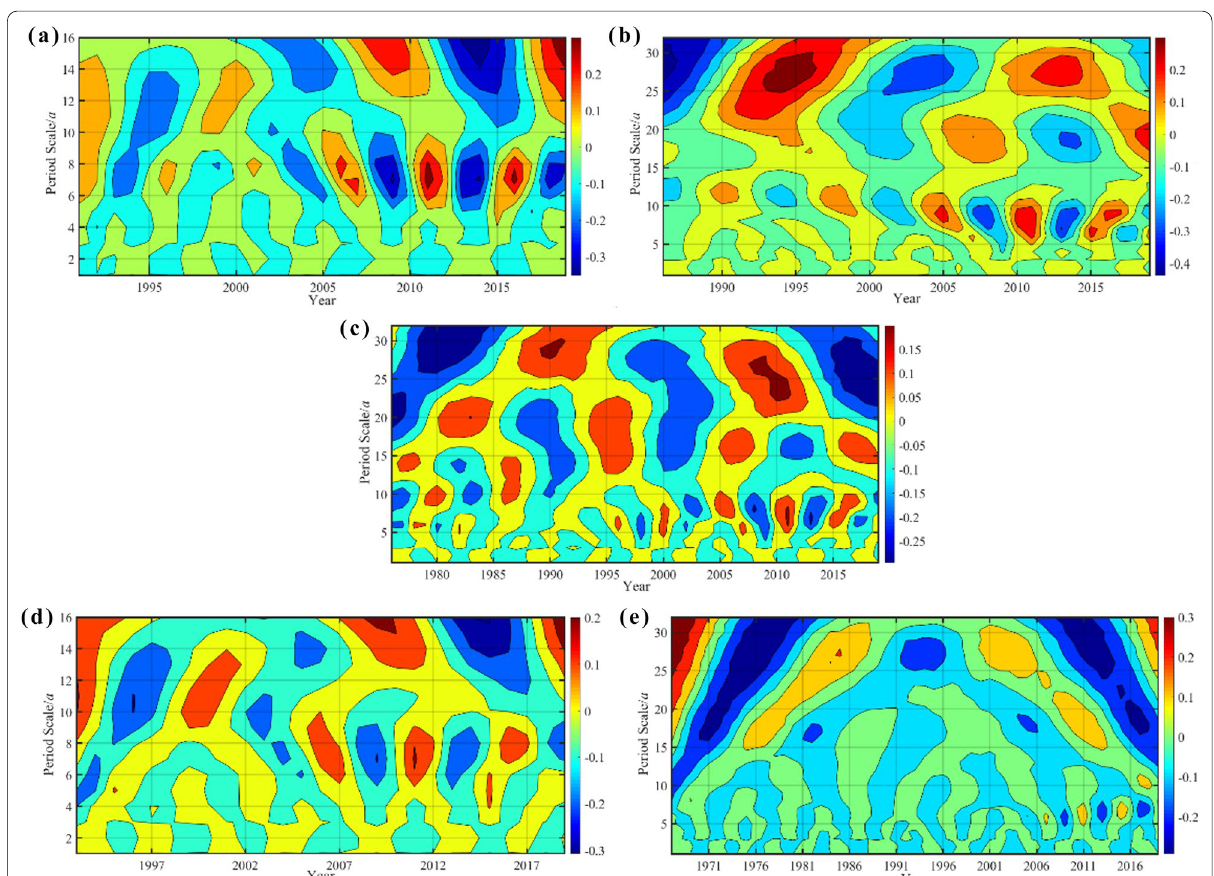
Fig. 7 Real part wavelet coefficient contour map of tree-ring width index at a low altitude, b middle altitude, c high altitude, d sunny slope, and e shady slope. Y -axis is the scale in year, and X -axis is the time in